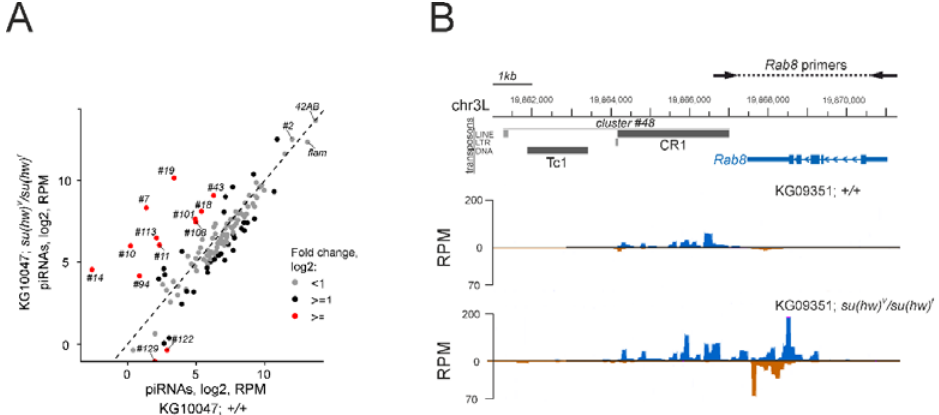
Figure 6. Su(Hw) depletion leads to increased production of piRNAs in distinct genomic sites. ( A ) Scatter plot of log2-transformed and RPM-normalized small RNAseq reads in the ovaries of wild type and su(Hw) V /su(Hw) f mutant flies mapped to piRNA clusters ( B ) Profile of the ovarian small RNA density at the Rab8 gene region located in close proximity to cluster #48, comprising of Tc1 and CR1 TEs, in wild type and su(Hw) V /su(Hw) f mutant flies. The increased production of small RNAs by both genomic strands in the Su(Hw) mutant background is shown. Small RNAseq data from the ovaries of KG10047 ;+/+ and KG10047 ; su(Hw) V /su(Hw) f strains were used in the figure. Genomic coordinates are indicated according to the dm6 genome assembly. PCR on genomic DNA using indicated primers did not reveal variations in the length of the Rab8 gene region.